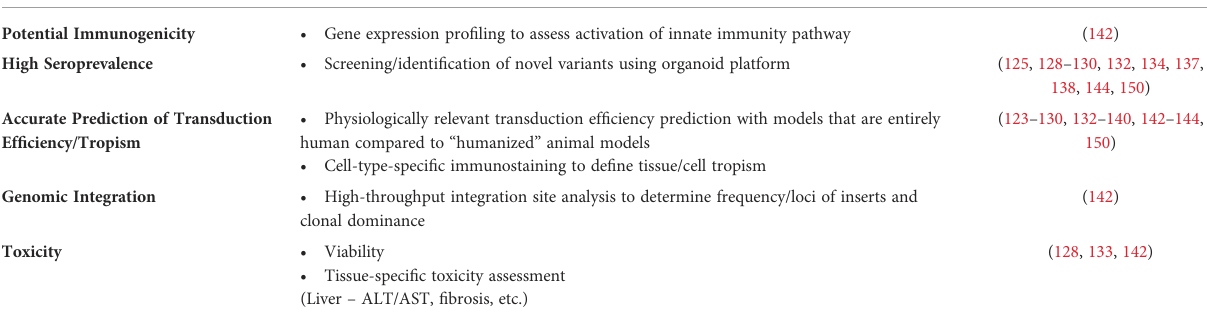
TABLE 1 Strategies of studies employing organoids and microphysiological systems to overcome the hurdles of AAV gene therapy. Hurdles of AAV gene therapy Novel models to overcome AAV gene therapy hurdles (Organoids and microphysiological